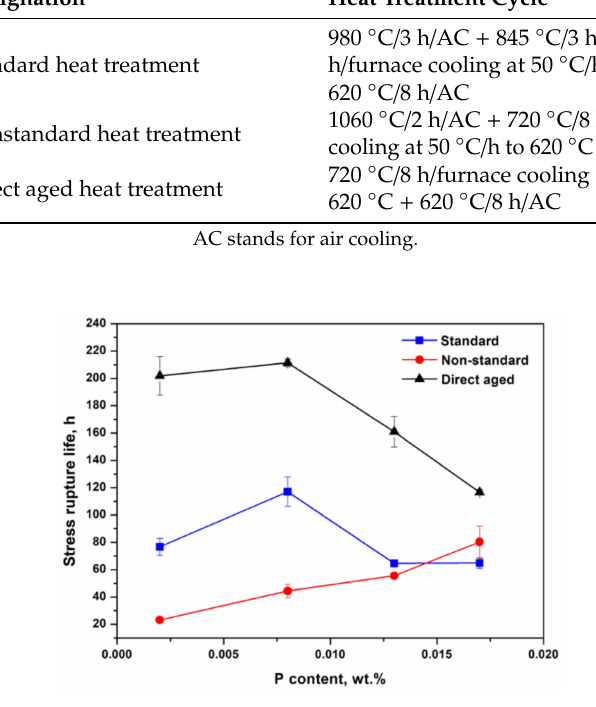
Figure 9. Time to rupture IN706 alloy with di ff erent P content under three heat treatment schemes. The samples with standard and direct aged schemes were tested at 650 ◦ C / 690 MPa. The samples with nonstandard scheme were tested at 650 ◦ C / 650 MPa